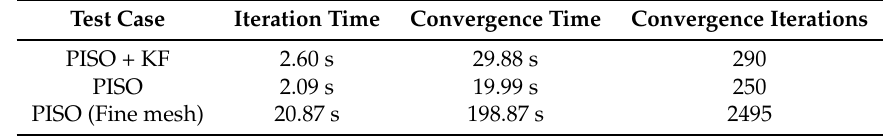
Figure 7. Time evolution of the maximum normalized L 2 error between observation and CFD solution. The red line is computed as the error between the reference solution computed on the fine grid, and the one evaluated on the coarser grid, without the correction by the filter. In the case of the green line, the CFD solution on the coarser grid has been corrected by the Kalman filter. Table 3. Comparison between the run times for the segregated method and the integrated